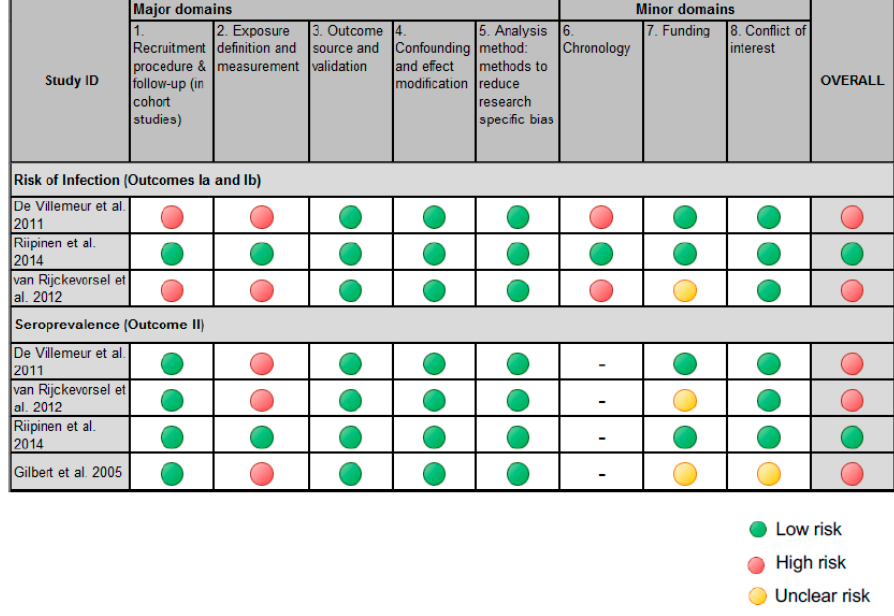
Figure 3. The risk of bias of the included studies.